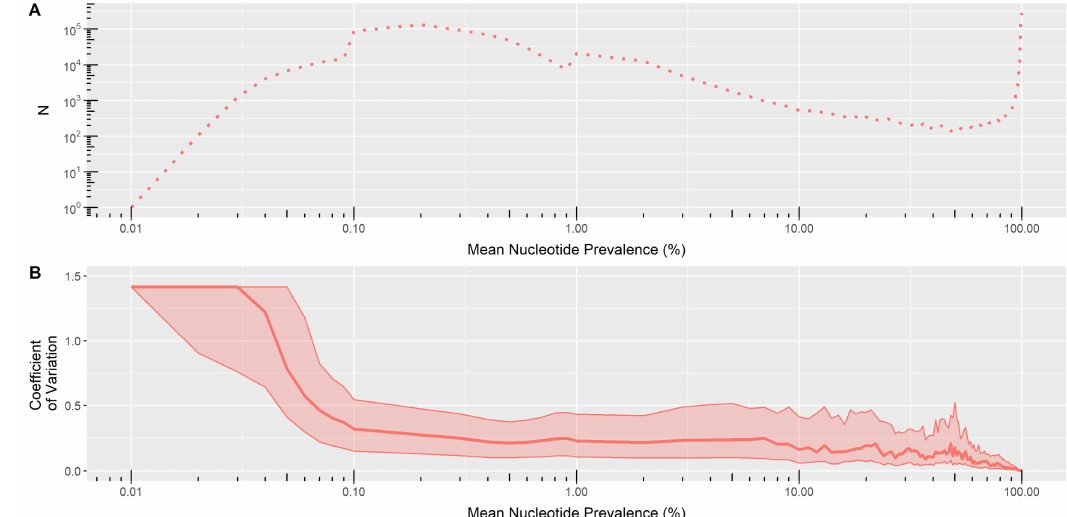
Figure 4. Assay sensitivity in detecting minority variants between sample duplicates at different mean nucleotide frequencies (defined as the mean prevalence of all permutations of nucleotides and positions within a sequence). This parameter was assessed using 95 samples run in duplicate, of which 84 passed sequencing. ( A ) The total number of nucleotide substitutions (N) detected at a particular mean substitution prevalence. ( B ) Median coefficient of variation (CV) of minor species with interquartile range (IQR) at different mean substitution